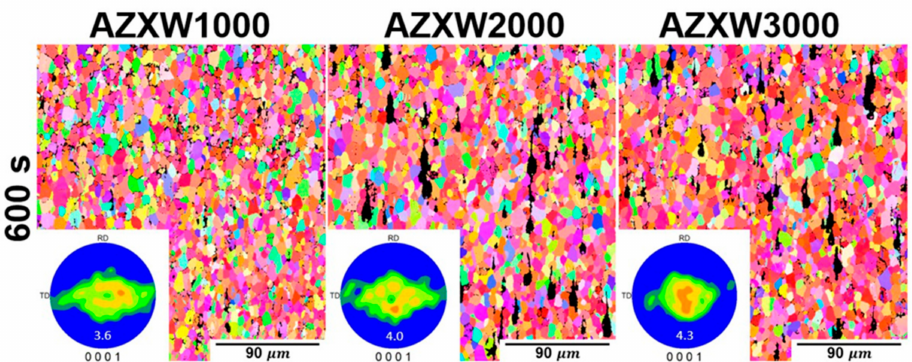
Figure 10. IPF maps and corresponding (0001) pole figures of the AZXW1000, 2000, and 3000 annealed for 600